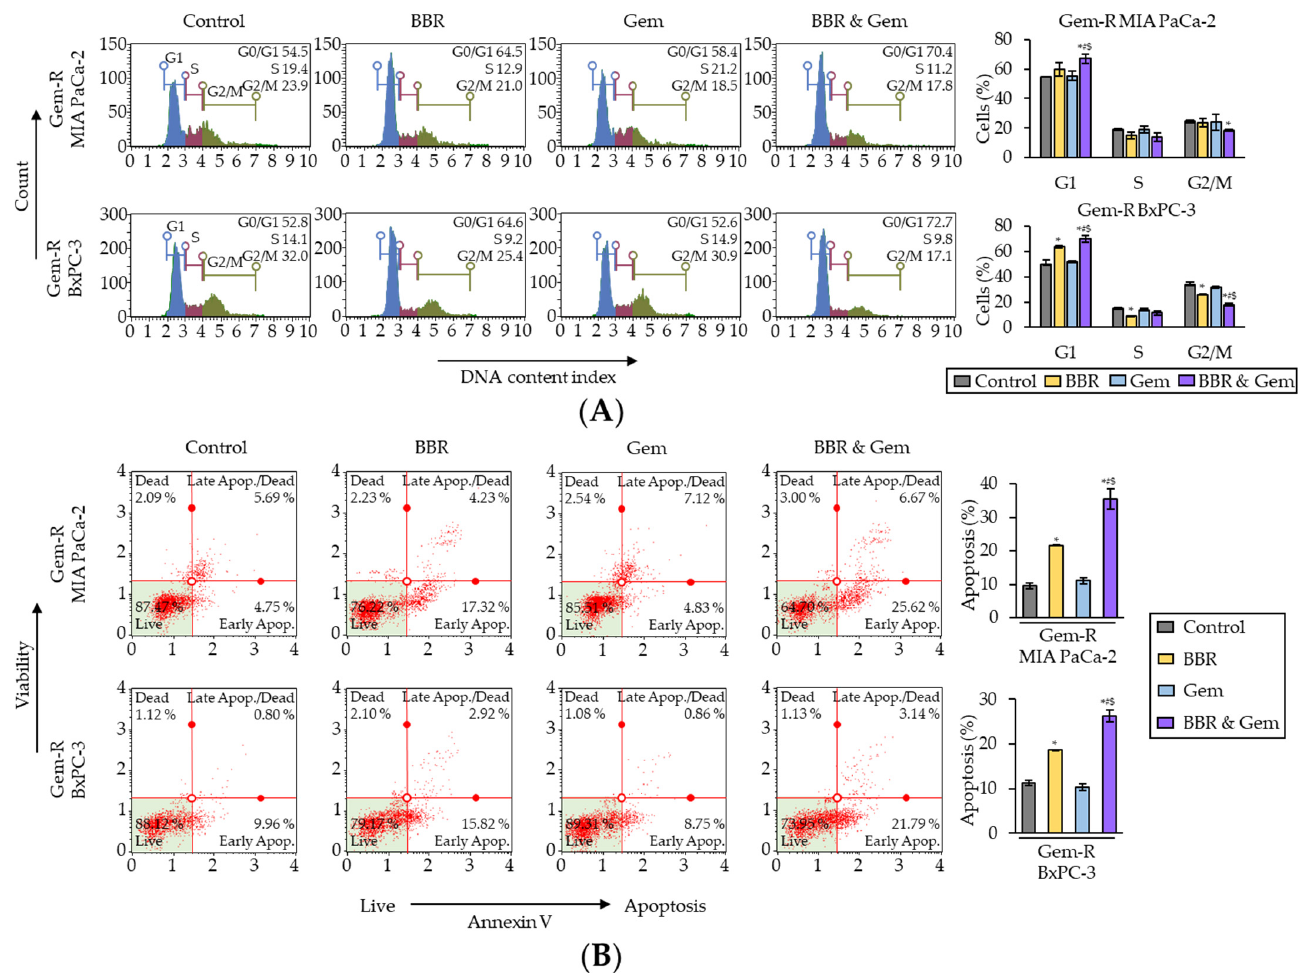
Figure 3. Berberine and Gemcitabine induce the G0/G1 phase cell cycle arrest and enhance cell apoptosis in Gemcitabine-resistant PDAC cells. ( A ) Representative images of cell cycle assays following treatment in Gem-R PDAC cells. The graph indicated the average ratio (column) ± SD of cells at each stage of cell cycle (* p < 0.05 vs. control, # p < 0.05 vs. BBR, $ p < 0.05 vs. Gem). ( B ) Representative images of apoptotic cells that stained for annexin V assays following treatment in Gem-R PDAC cells. The average ratio (column) ± SD of cells undergoing apoptosis is indicated (* p < 0.05 vs. control, # p < 0.05 vs. BBR, $ p < 0.05 vs. Gem). Gem-R, Gemcitabine-resistant; PDAC, pancreatic ductal adenocarcinoma; BBR, Berberine; Gem, Gemcitabine; SD, standard deviation.